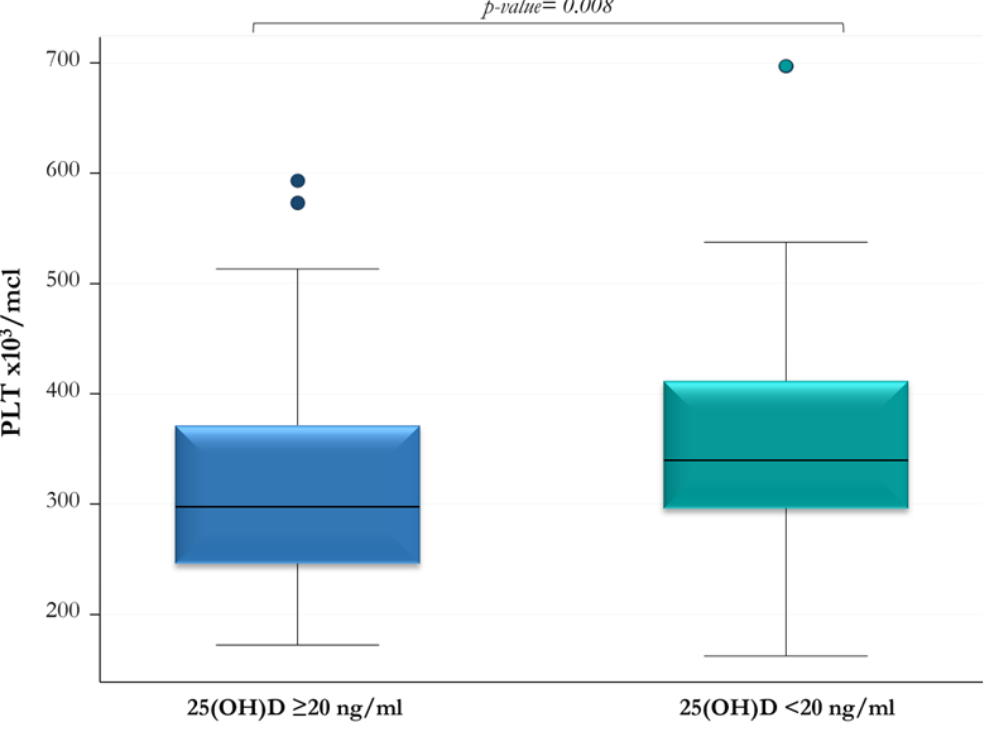
Figure 3. Platelet count (PLT) in OSAS patients with serum 25(OH)D levels ≥ 20 ng/mL and <20 ng/mL,